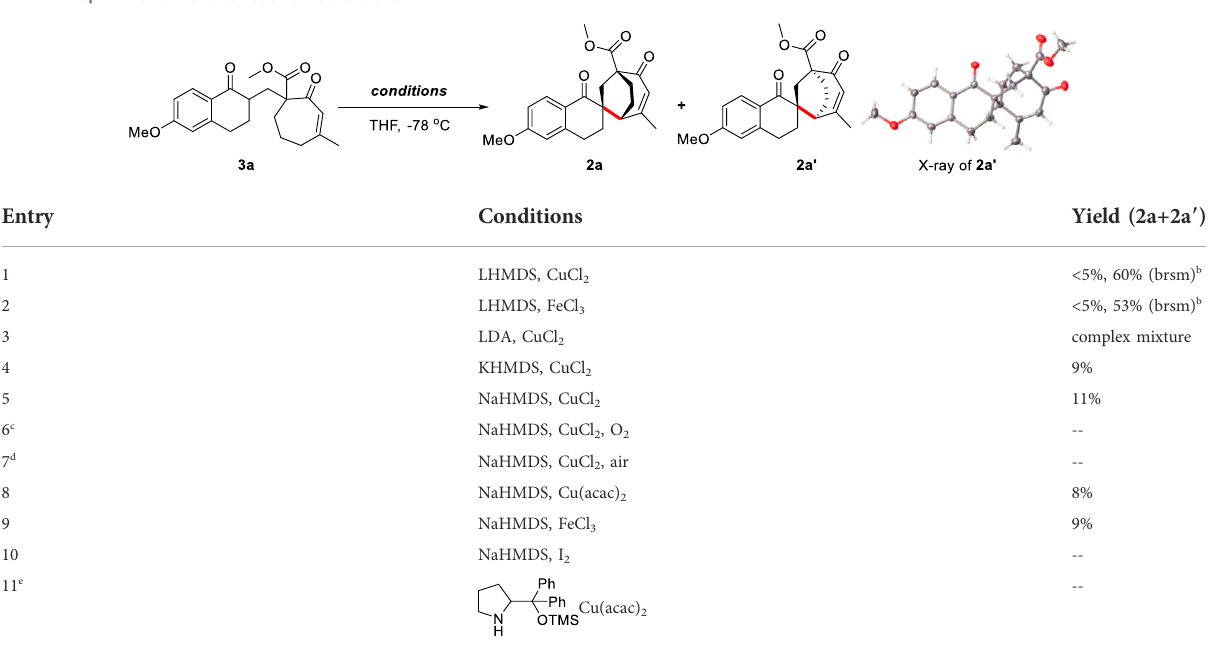
TABLE 1 Optimization of the reaction conditions a